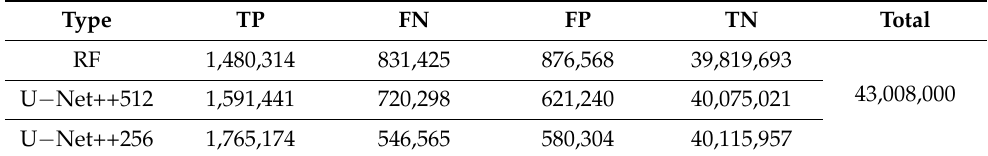
Table 3. Value of confusing matrix on different models.